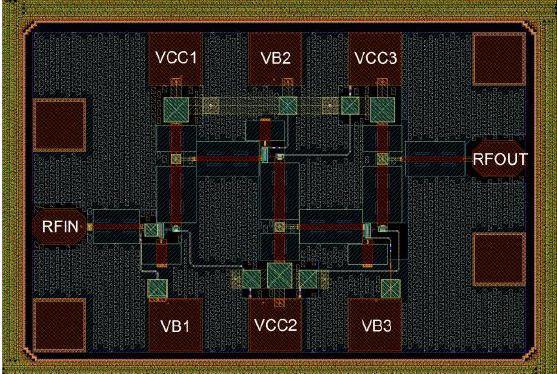
Fig. 2. Full layout of the 3-stage cascode